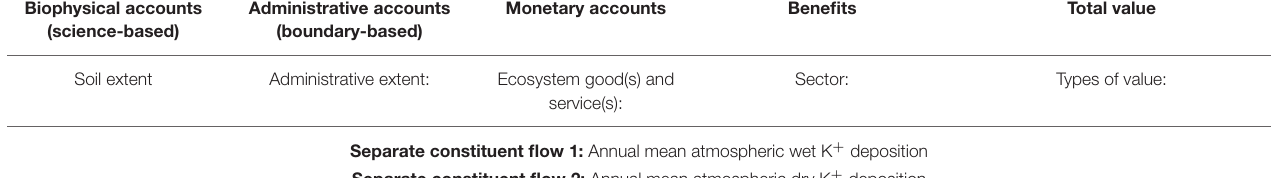
TABLE 1 | Conceptual overview of the annual atmospheric K + deposition accounting framework used in this study (adapted from Groshans et al., 2018b). Biophysical accounts